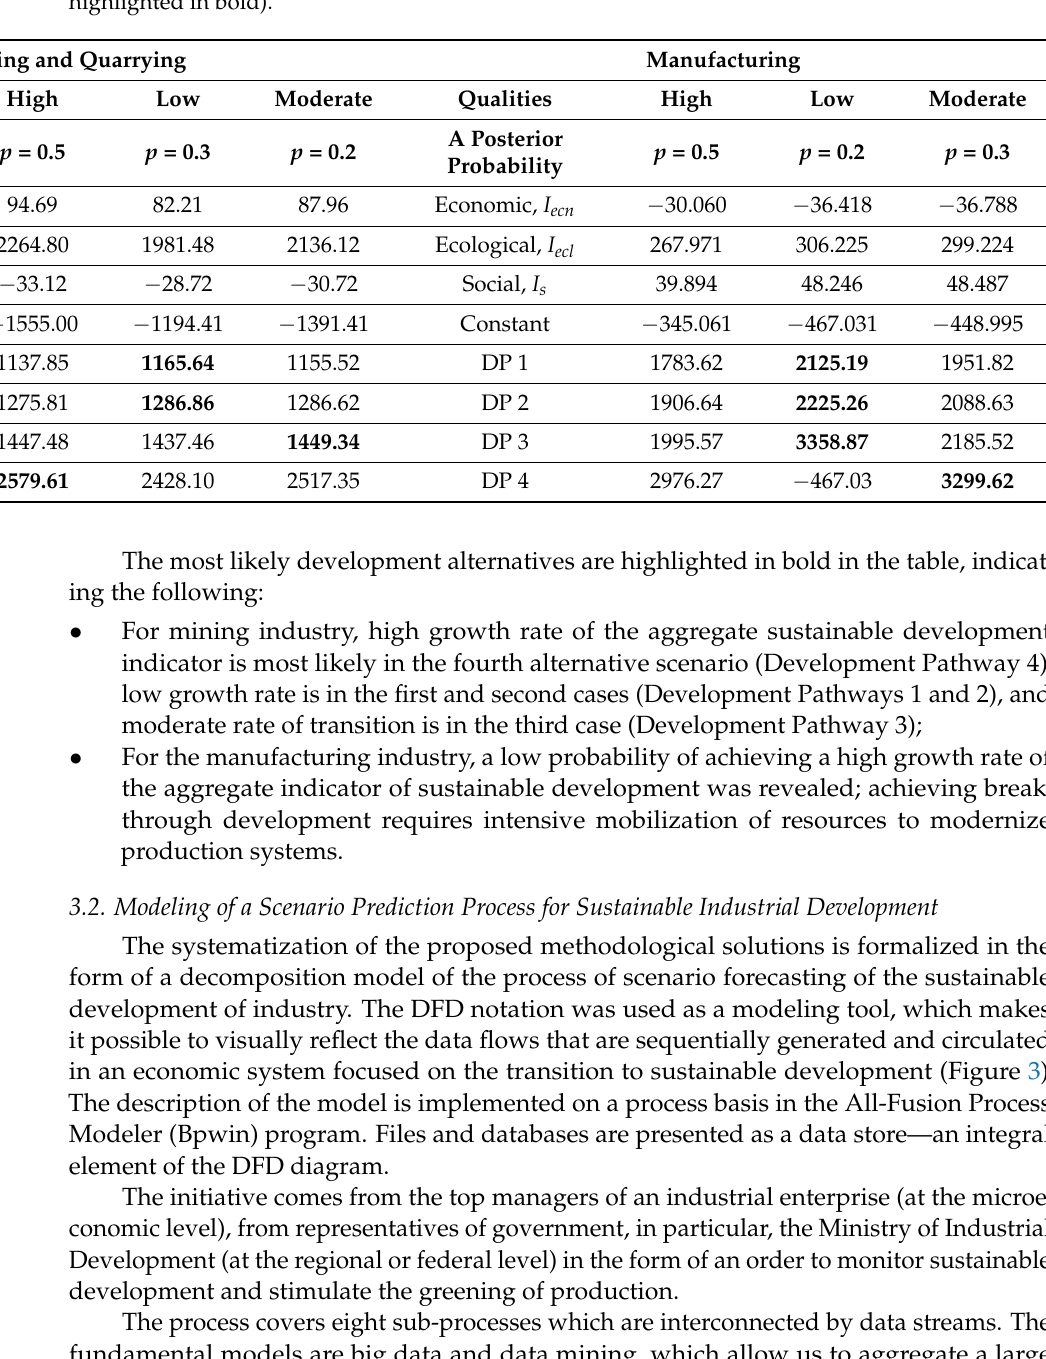
Table 7. Alternative trajectories of industrial development in Russia (the best values (the largest) are highlighted in